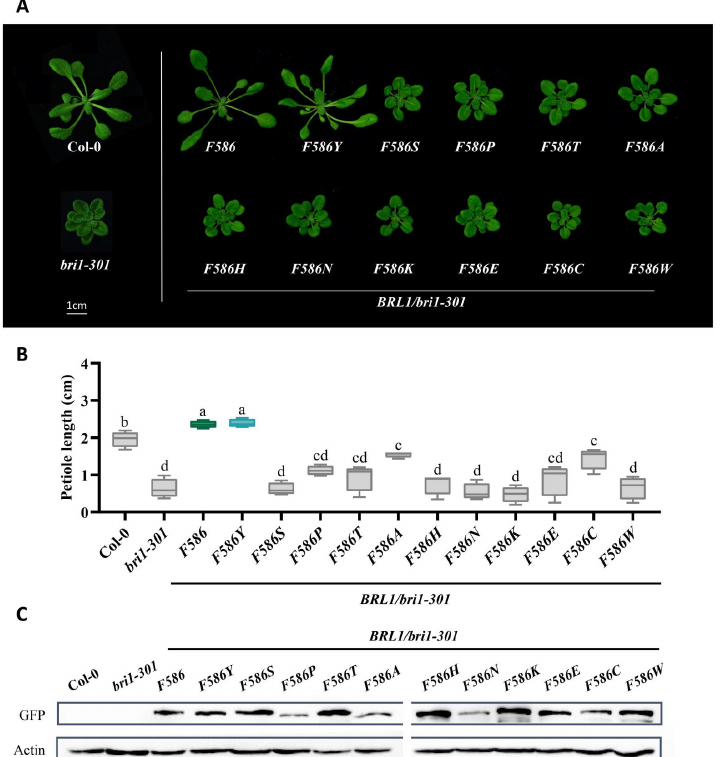
Figure 5. Both tyrosine and phenylalanine at position 586 of AtBRL1 (corresponding to residue 599 of AtBRI1) presented the strongest phenotypes. ( A ) Phenotypes of wild-type Col-0, bri1-301 , and transgenic plants with mutated receptors expressed in bri1-301 . Scale bar = 1 cm. ( B ) Petiole length analysis of the plants shown in ( A ). The results are represented as the means ± SD. The blue box highlights tyrosine fixed in BRI1, the green indicates Phenylalanine586 of BRL1/3, and the grey rep- resents the remaining amino acids. Different letters indicate significant differences ( n = 15, p < 0.0001, one- way ANOVA with a Tukey’s test). ( C ) Protein expression analysis of GFP-tagged mutated re- ceptors in transgenic plants. An anti-GFP antibody was used to quantify the expression level. 2.4. BR Receptors with Tyrosine597 or Tyrosine599 Showing the Highest Biochemical and Physiological Efficacy in BR Signaling During evolution, Tyrosine597 and Tyrosine599 change BR signaling in different manners, so we asked whether these changes also happen at the biochemical and physio- logical levels. To answer this question, we examined the dephosphorylation vs.